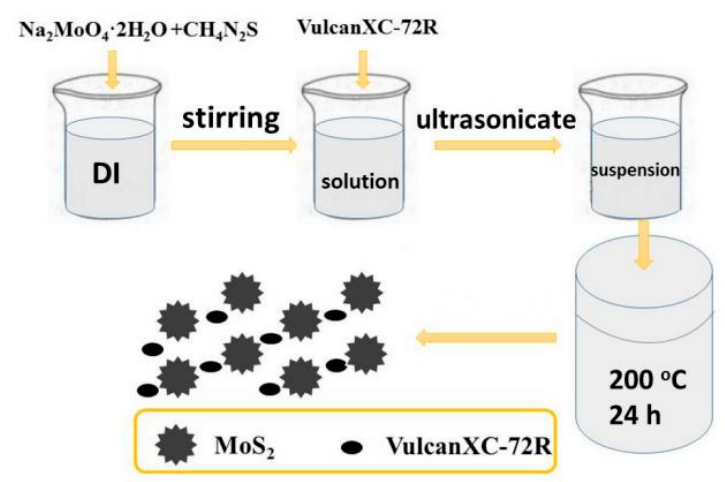
Figure 10. Continuous cyclic voltammograms of different modified electrodes: ( A ) MoS 2 /C com- posite, ( B ) in O 2 -saturated 0.1 HClO 4 solution, and ( C ) Pt/C in O 2 - saturated 0.1 M KOH solution. Scan rate: 20 mV s − 1 .